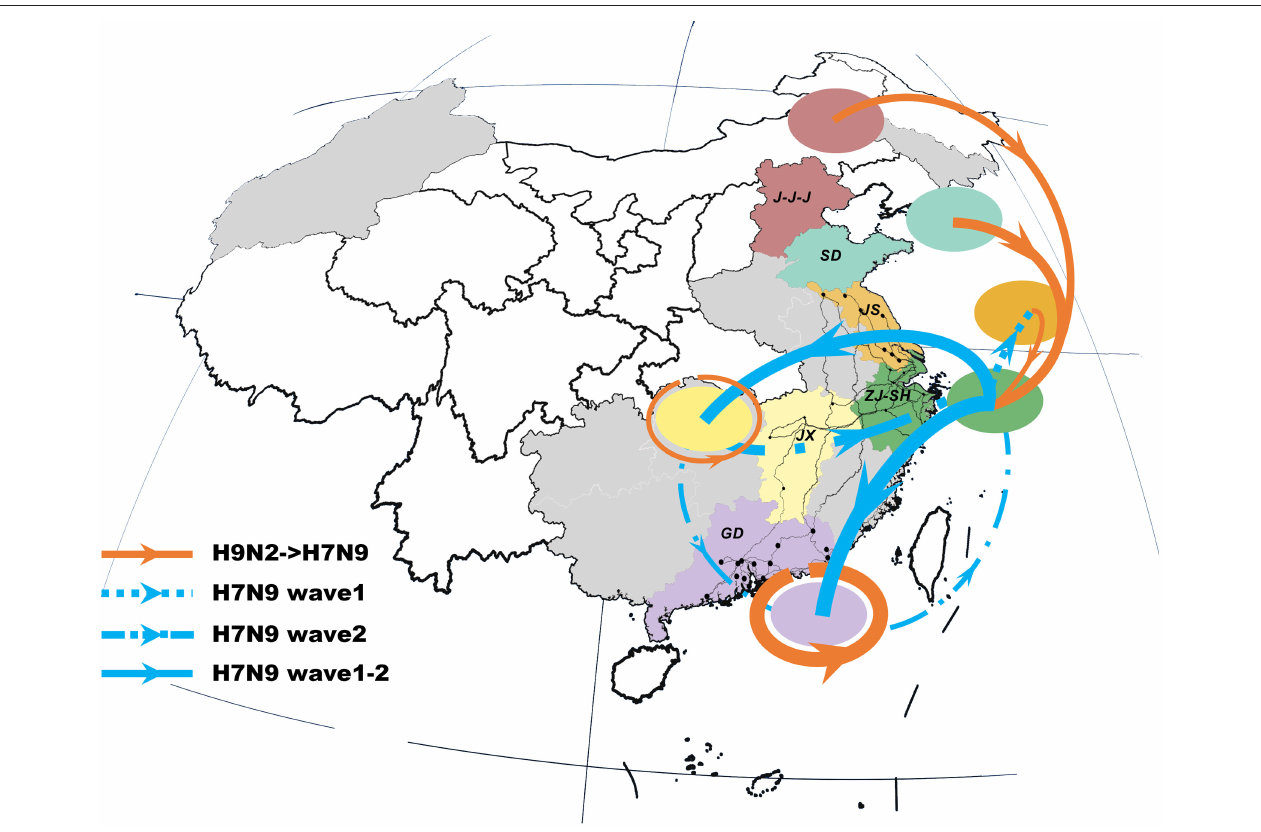
FIGURE 2 | Viral propagation network for internal gene segments of H9N2-H7N9 viruses. Viral migration routes are distinguished by subtype, epidemic wave, and strength. Specifically, orange ones represent interaction between H9N2 and H7N9 viruses; while the blue dot lines, dash-dot lines and solid lines with arrow indicate the viral migration pattern of H7N9 in wave 1, wave 2 and persist during two epidemic waves, respectively. The linkage strength is represented by the number of occurrence in all internal segments. Locations with H7N9 human cases included in the study are colored and those not included are shaded gray. The primary national roads and cities with H7N9 human cases are represented by black lines and black dots, respectively. J-J-J, Beijing–Tianjin–Hebei region; SD, Shandong; JS, Jiangsu; SH-ZJ, Shanghai–Zhejiang region; JX, Jiangxi; GD,